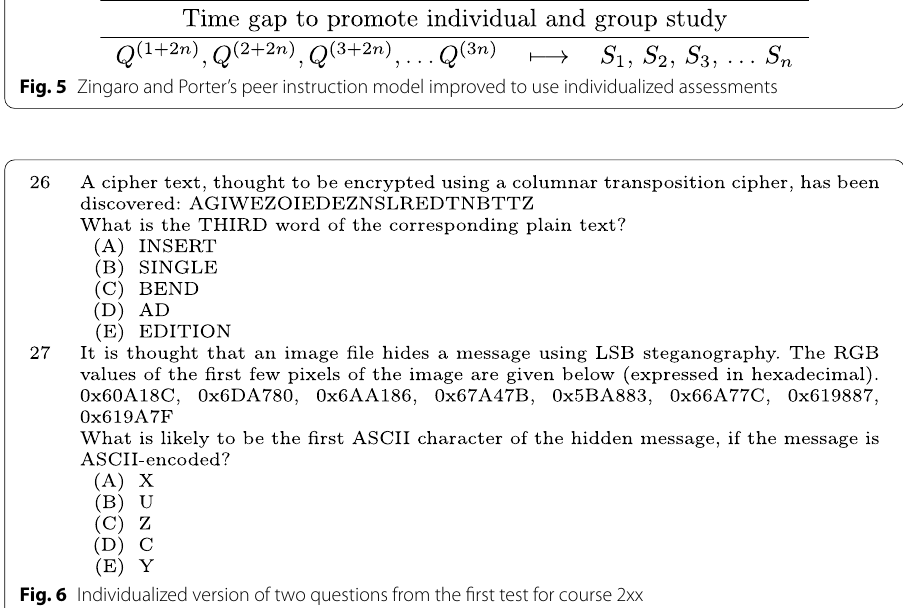
Fig. 6 Individualized version of two questions from the first test for course